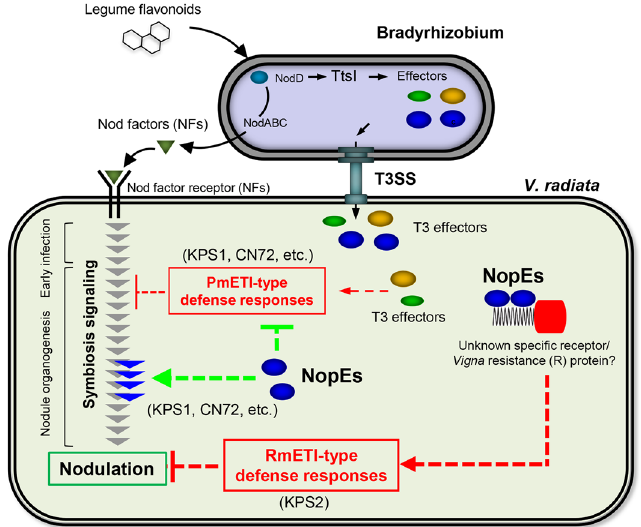
Figure 8. Putative models of host genotype-specific symbiotic interactions between bradyrhizobia and V. radiata varieties may be controlled by type III effector NopEs. Hypothetically, NopEs are